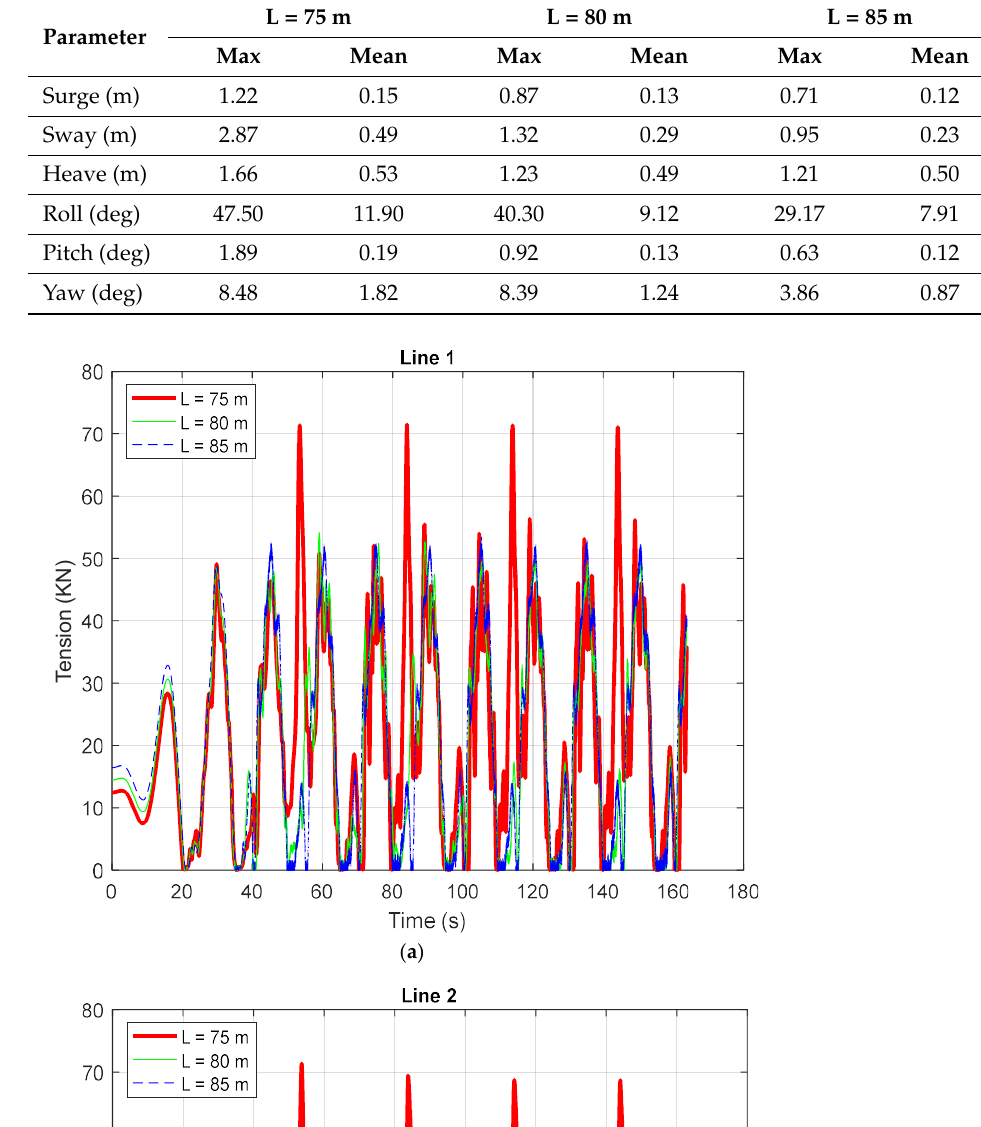
Table 5. Comparison of 6 DOF motions of foundations with different mooring lengths.